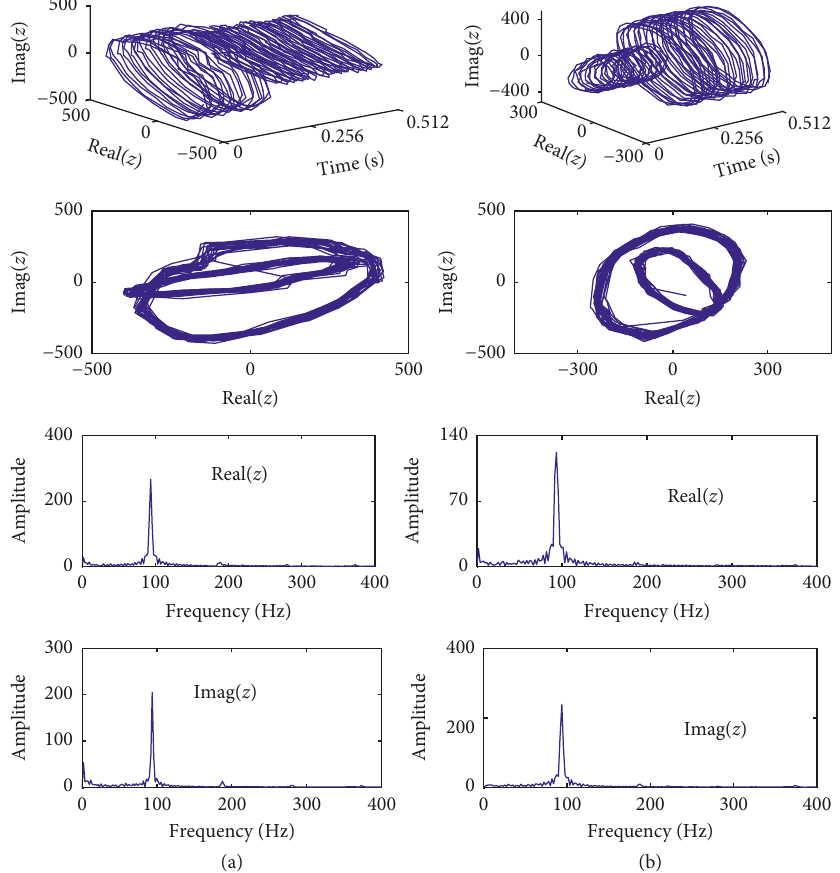
Figure 24: The time and frequency domain plots of the bistable behavior signals.